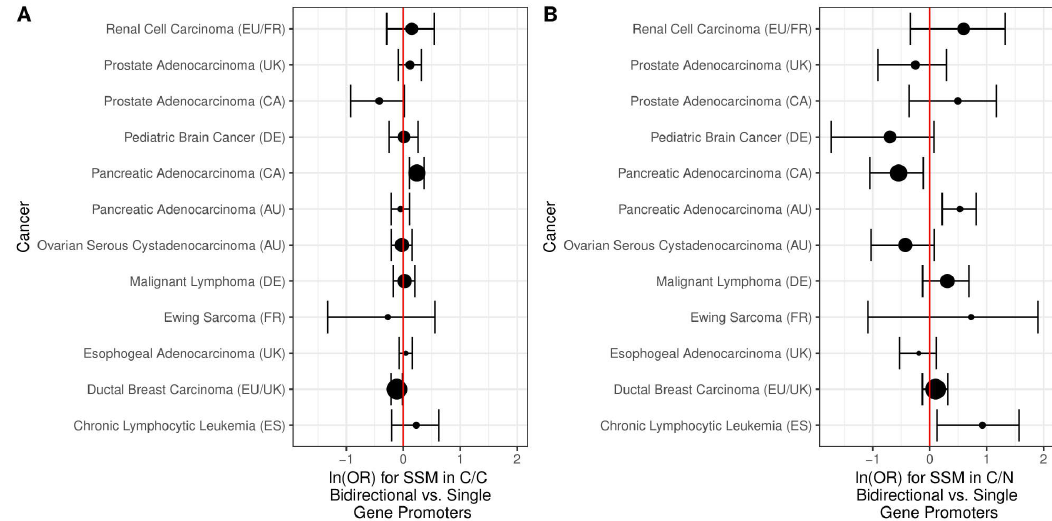
Figure 5. The log odds of simple somatic mutations in CpG islands in bidirectional vs. single gene promoters. ( A ) For C/C bidirectional promoters, after subsetting to CpG islands, the only statistically significantly greater odds of SSMs remaining is for the Canadian pancreatic cancer dataset; ( B ) For C/N bidirectional promoters, after subsetting to CpG islands, the only statistically significantly greater odds of SSMs is the Australian pancreatic cancer dataset and the leukemia dataset. Furthermore, the Canadian pancreatic dataset has significantly reduced odds of SSMs compared to single gene promoters.